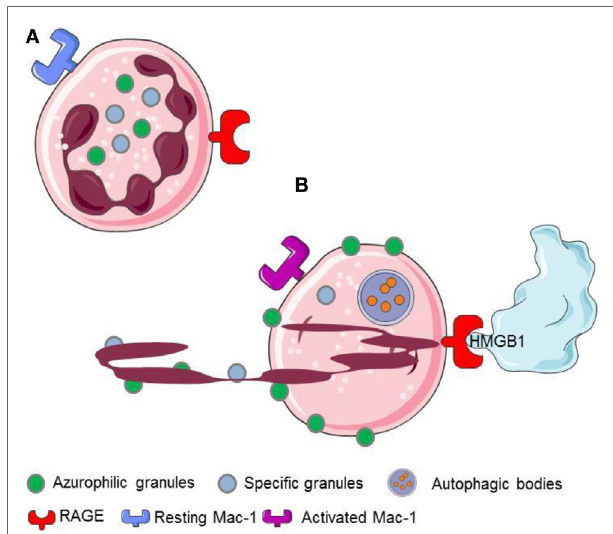
FiGURe 2 | HMGB1 released or expressed by activated platelets recognizes RAGe expressed on neutrophils . (A) Resting neutrophils express non activated Mac-1 and RAGE on their surface. (B) HMGB1 expreesed by activated platelets induces neutrophils to initiale autophagy, promotes the redistribution of neutrophil granules, induces the transactivation of Mac-1 and elicits the NETs